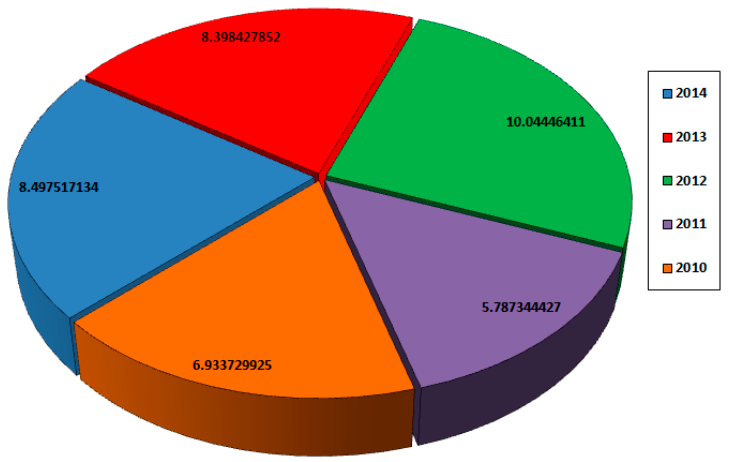
Figure 9. Electrical power output in the Mediterranean Sea (MW).